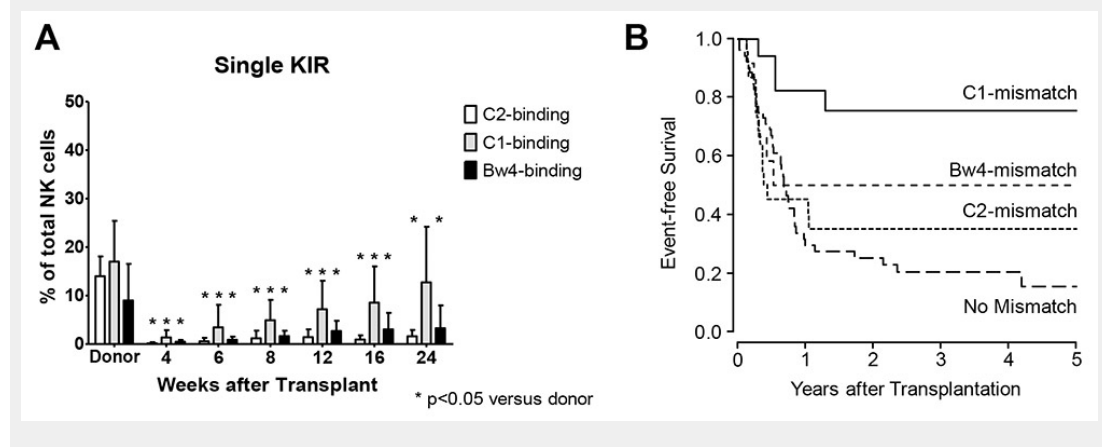
Figure 2 Temporal evolution of the frequencies single KIR expressing NK cells as percentage of total NK cells shows a skewed repertoire with slow reconstitution of single KIR expressing subsets. Reconstitution is fastest for C1-binding KIR, followed by Bw4 binding KIR and C1-binding KIR. This is mirrored in survival curves of patients stratified by type of KIR ligand mismatch, with best survival seen in patients transplanted from a donor KIR ligand mismatched for a receptor that reconstitutes early after transplantation (adapted from Stern M, de Angelis C, Urbani E, Mancusi A, Aversa F, Velardi A, L Ruggeri L. Natural killer-cell KIR repertoire reconstitution after haploidentical SCT. Bone Marrow Transplantation.